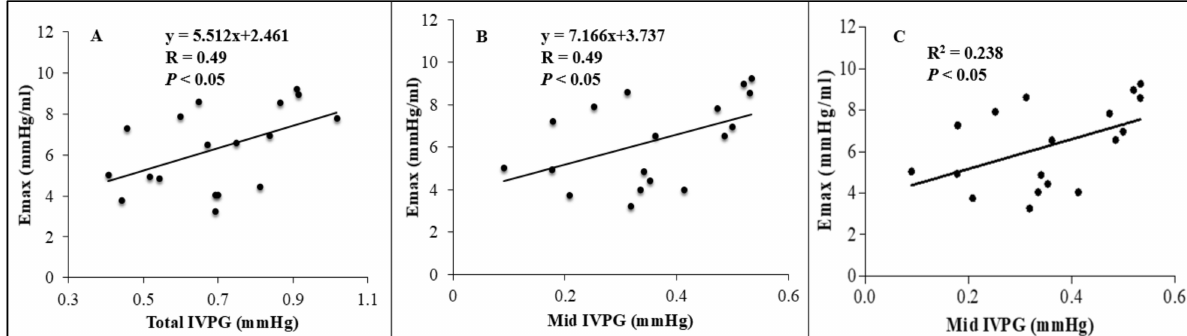
Figure 3. ( A , B ) Pearson’s correleation between changes in Emax: left ventricular end-systolic pressure-volume, and total- and mid-IVPG: intraventricular pressure gradient showed significant positive correlation (r = 0.49, p < 0.05, both ( A , B )). ( C ) linear regression analysis of Emax and mid-IVPG revealed that mid-IVPG was a predictor of Emax (R 2 = 0.0.238, adjusted R 2 = 0.190, p <